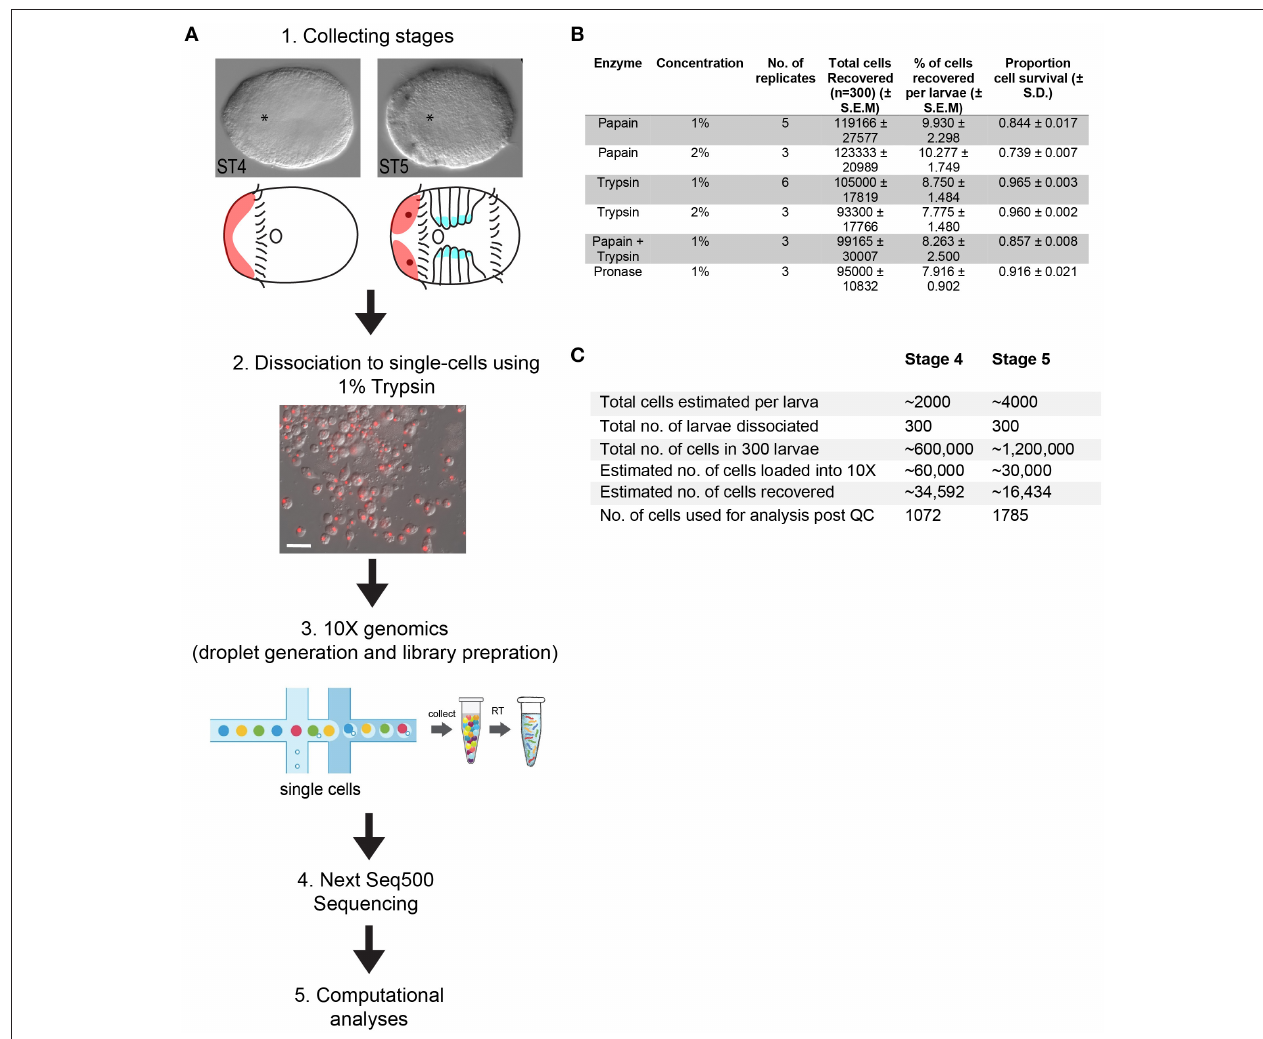
FIGURE 1 | (A) Single-cell transcriptomics of stage 4 and 5 Capitella teleta larvae. Whole-body stage 4 and 5 (1) larvae were dissociated into single cells using a combination of mechanical and enzymatic dissociation. In the diagrams in (1), colors represent the anterior (red) and the ventral (blue) nervous system anlagen. Image showing cell suspension dissociated using 1% Trypsin ( ∼ 96.5% viability) resuspended in cell-media post filtering and centrifugation, 45min after dissociation. Red – Hoechst + nuclei (2). Individual cells were randomly selected for droplet generation using the 10X Genomics Chromium Platform (3). Single-cell transcriptomes were pooled and sequenced using NextSeq500 High-output method (4) generating 573 million reads across the two samples. Sequences obtained were curated and aligned to the C. teleta genome v1.0 followed by application of downstream computational pipelines for clustering, trajectory analysis, pseudotime analysis and estimating RNA dynamics (5). (B) Table showing the different proteolytic enzymes tested across different concentrations for optimizing C. teleta cell dissociation protocols using stage 4 larvae. The first two columns indicate the enzymes and the respective concentrations used. The third column shows the number of biological replicates for each enzyme conducted, the fourth column indicates the total number of cells ( ± S.E.M) quantified post-dissociation from 300 stage 4 larvae, the fifth column indicates the percentage of cells recovered per stage 4 larvae ( ± S.E.M) and the sixth column shows the proportion of healthy cells ( ± S.D.) quantified following a Trypan Blue exclusion test 1h post-dissociation using the respective enzymes. (C) Table showing the number of cells used for dissociation to sequencing and bioinformatic analysis. Scale bar – 10 µ m.